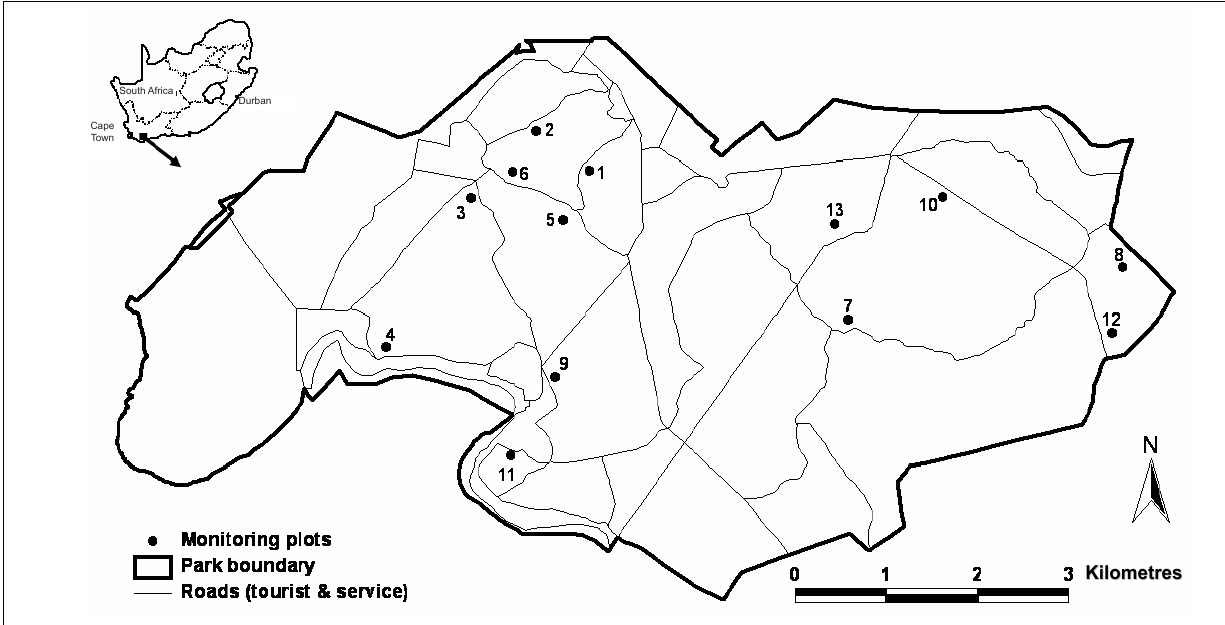
FIGURE 1 The Bontebok National Park showing the locations of the monitoring